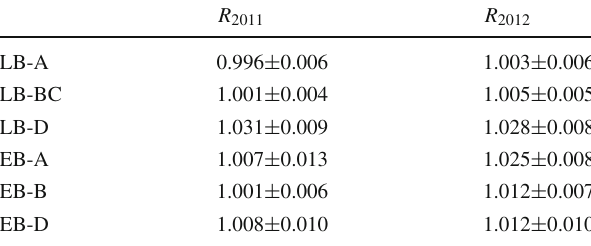
Table 8 Double ratio given in Eq. (4) by the ratio of the experimental and simulated (cid:4) E /(cid:4) x truncated means for different layers in the long barrel (LB) and extended barrel (EB), using isolated muons from W → μν in data and MC events in 2011 and 2012. The sources of uncertainty are described in the text